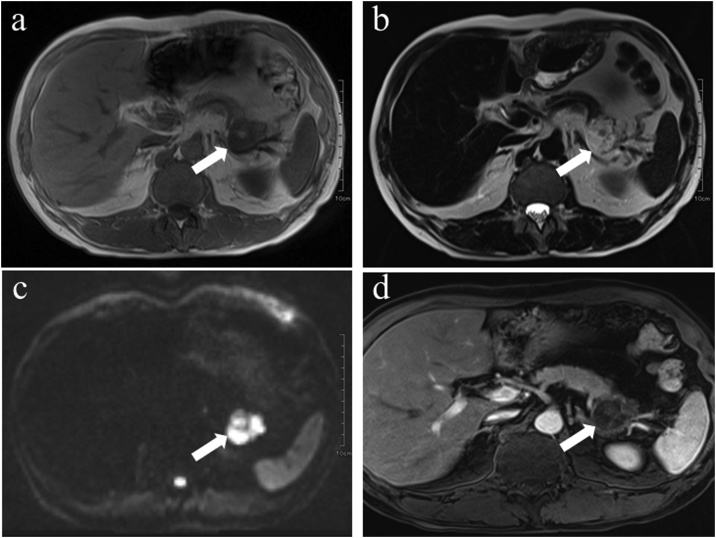
Magnetic resonance imaging (MRI): A. MRI demonstrated a multiple-ball-like lesion of low signal intensity on T1-weighted image (arrow). B. MRI showed the same lesion with high signal intensity on T2-weighted image (arrow). C. MRI showed high signal intensity in the central and iso-signal intensity in the peripheral portions of the cystic lesion on diffusion-weighted image (arrow). D. Enhanced MRI showed high signal intensity in the cystic wall and septa and low signal intensity of the cystic contents (arrow).